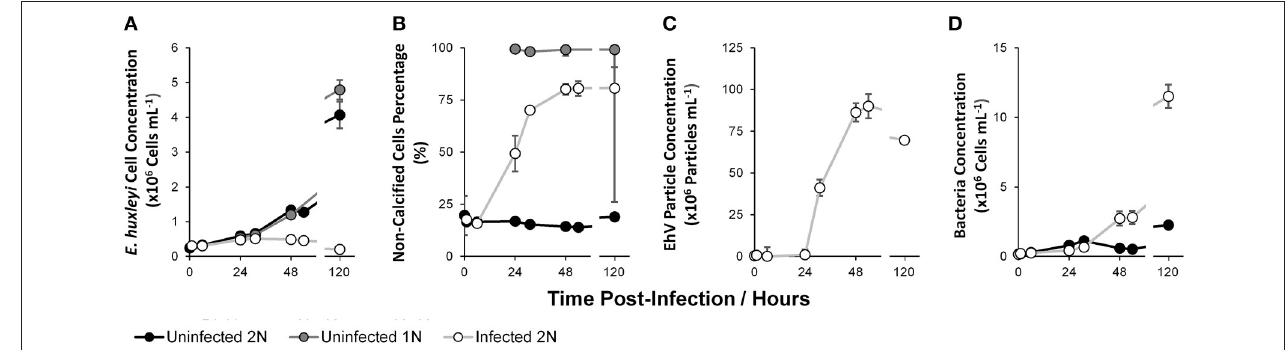
FIGURE 1 | Host cell and viral dynamics during infection: Total Host Cell Concentration (A); Non-calcified Cell Percentage of Total (Host Cell, B); EhV Particle Concentration (C); Bacterial Cell Concentration (D). Data represent the mean average of two biological replicates with error bars of one standard